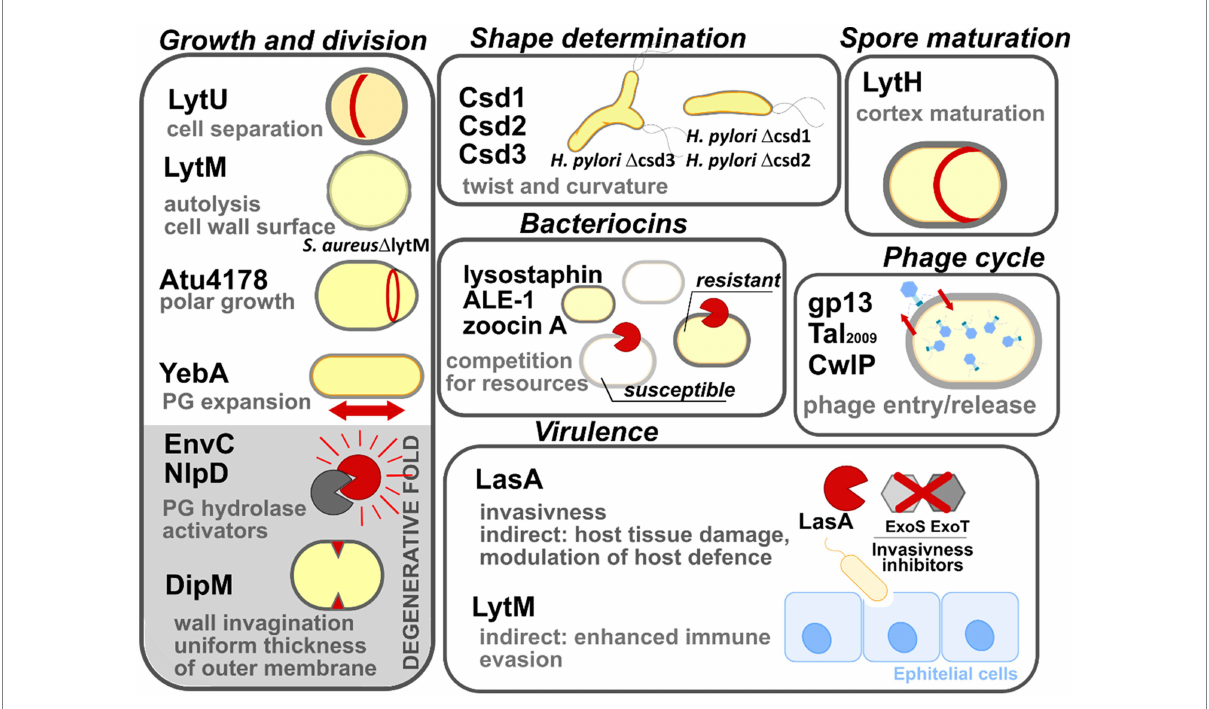
FIGURE 7 Multiple biological roles of M23 peptidases. The enzymes are grouped here according to their biological roles: growth and division, shape determination, spore maturation, intraspecies competition (bacteriocins), phage lytic cycle, and bacterial virulence. M23 family members that display degenerative folds are shown on the gray background. All abbreviations used have been explained in the